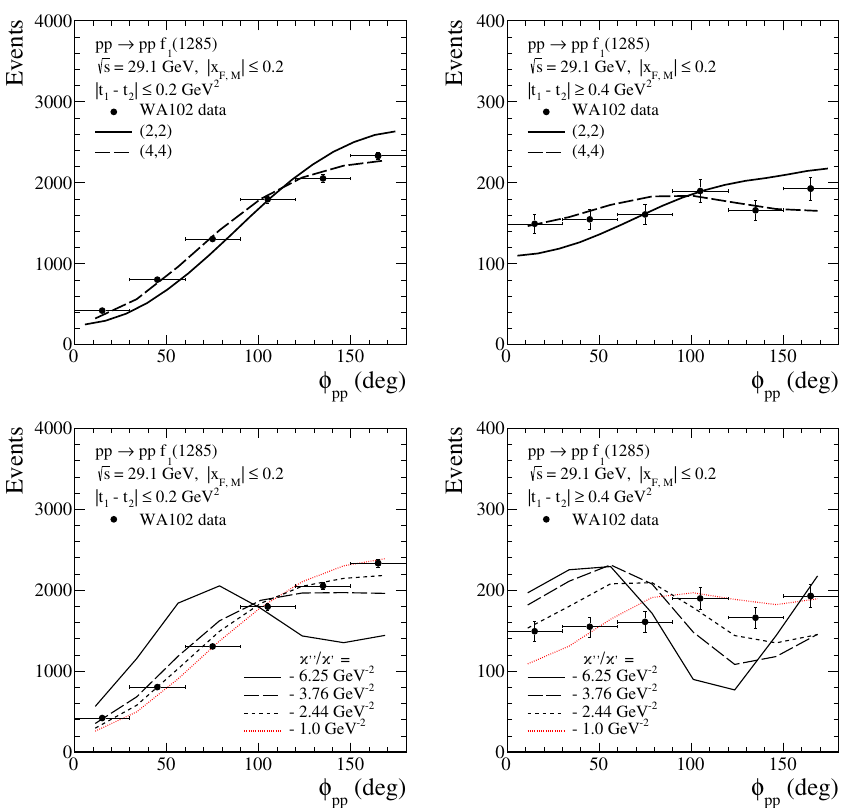
(cid:112) ( 1285 ) meson production at Figure 2: The φ s = 29.1 GeV, distributions for f pp 1 | x | (cid:182) 0.2, and for | t − t | (cid:182) 0.2 GeV 2 (left panels) and | t − t | (cid:190) 0.4 GeV 2 (right panels). F , M 1 2 1 2 The WA102 experimental data points are from Fig. 3 of [ 14 ] . The theoretical results have = 0.7 GeV a been normalised to the mean value of the number of events. The results for Λ E form-factor parameter are